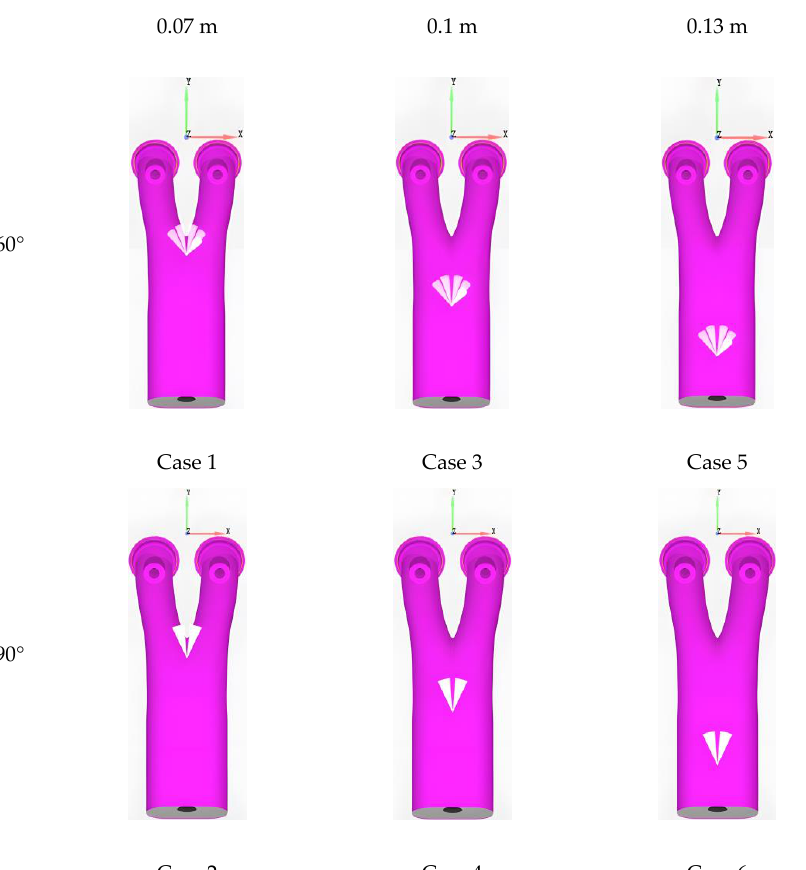
Figure 8. Diagram of the installation position of six different water injectors. Table 9. Water injection parameters.